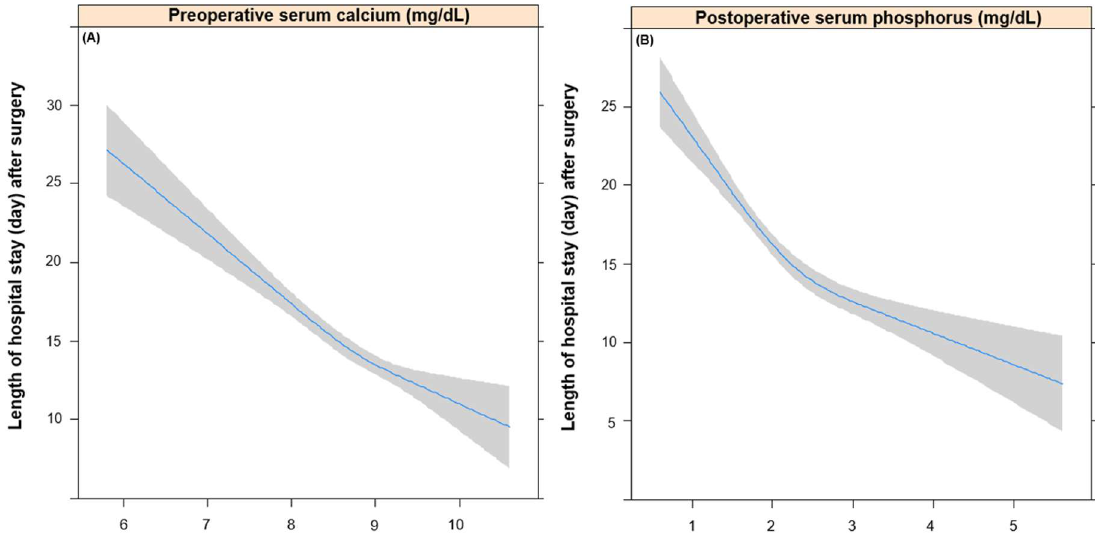
Figure 3. Relationship between length of hospital stay and preoperative calcium ( A ) and postoperative phosphorus ( B ). phosphorus ( B